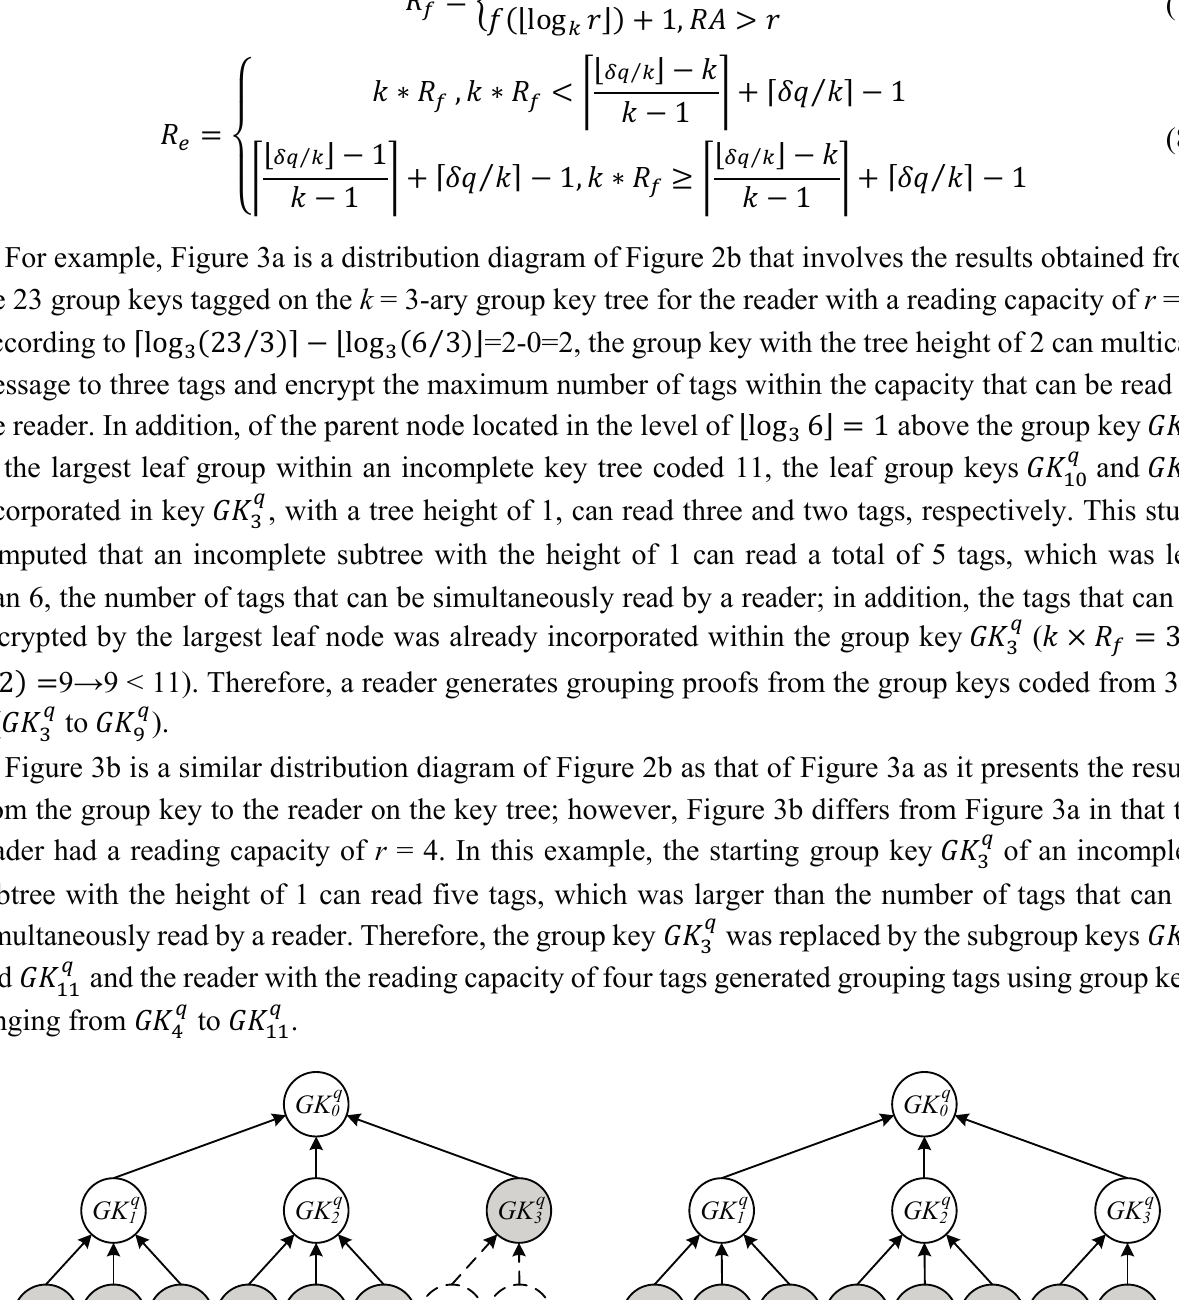
− (cid:1844) + 1 number of group (cid:3032) (cid:3033)